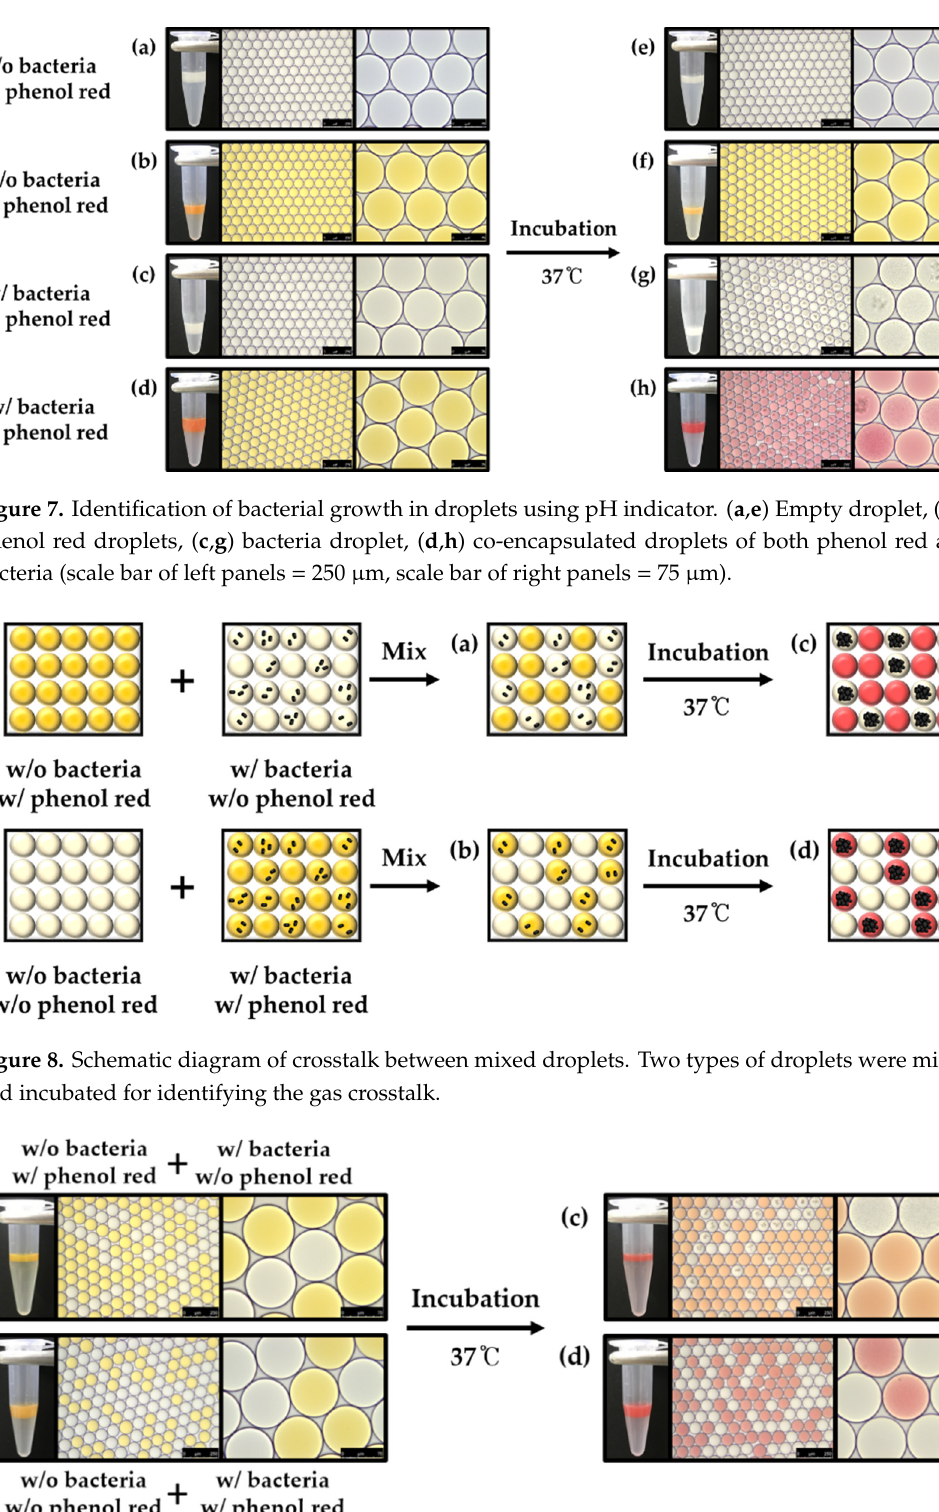
Figure 6. Schematic diagram of the experimental plan to determine bacterial growth by cultivation within droplets using s pH indicator. ( a ) Empty droplets, ( b ) phenol red droplets, ( c ) bacteria droplets, ( d ) phenol red and bacteria droplets for the incubation and detection by the color change of phenol red.